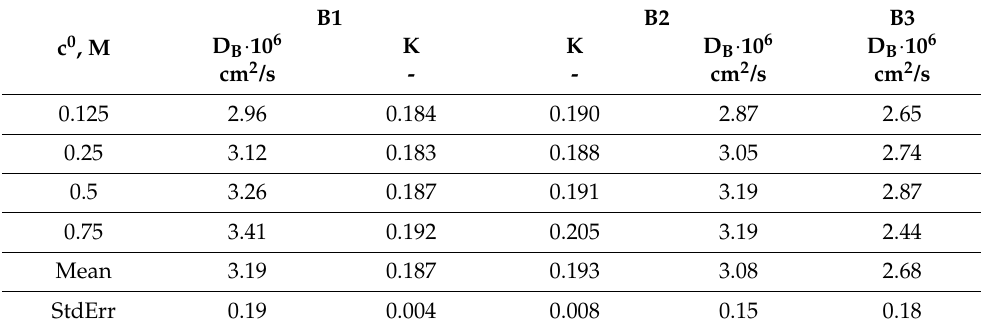
Table 2. Values of the diffusion coefficient of Br − inside the membrane, D B , and of its distribution coefficient, K, based on results for various procedures in Table 1, B1 to